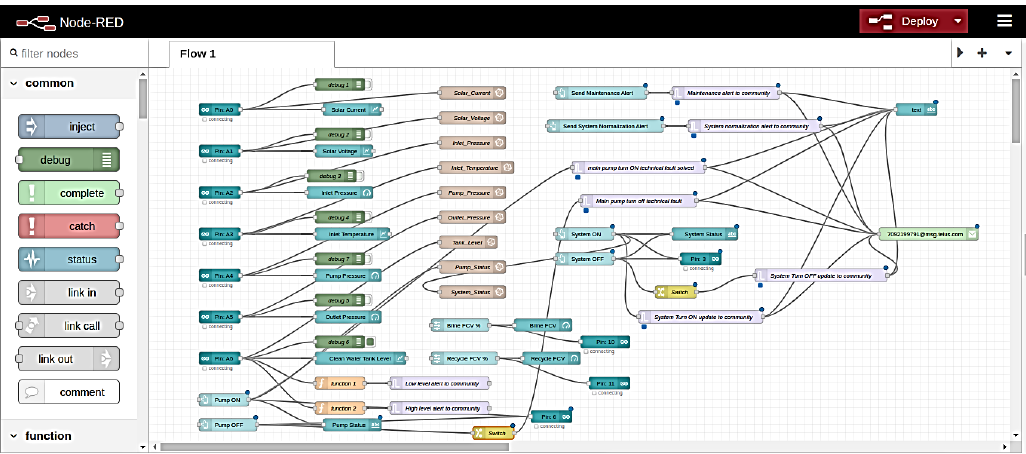
Figure 10. Node-Red programming of the system. The Node-Red dashboard was created with all major functions required for smooth system operation and sending messages and alerts to the community. Figure 11 shows the Node-Red Operational dashboard available for the user.